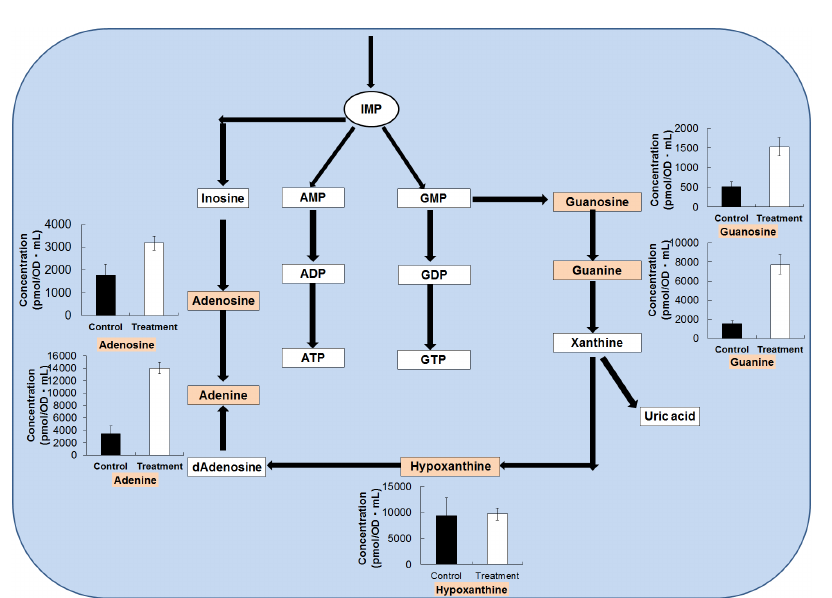
Fig 6. Alteration of the metabolites in the purine nucleotide biosynthesis pathway. The changesin metabolitelevels in the fermented O . japonicus by L . plantarum (gray bars) compared with those in the O . japonicus with L . plantarum (black bars) were elucidated by capillary electrophoresis time of flight mass spectrometry (CE-TOF-MS). The error bars indicate the mean standard deviationof triplicate samples. The figure also includesa schematic diagram of the purinenucleotidebiosynthesis